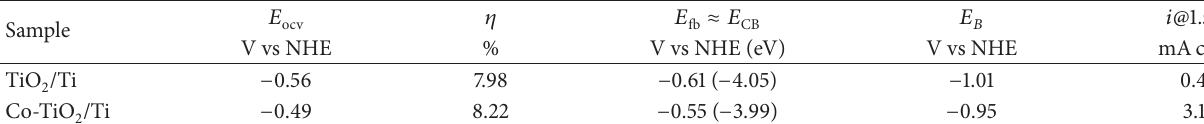
Table 1: Photo-electrochemical characteristic of TiO